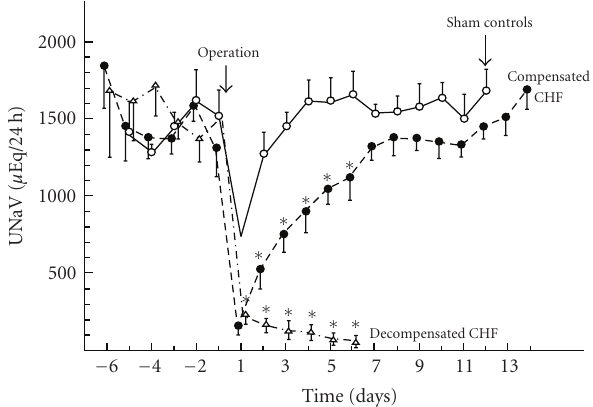
Figure 2: Daily urinary sodium excretion (UNaV) in rats with arteriovenous (AV) fistula and in sham controls. Notice 2 distinct patterns of sodium excretion in rats with AV fistula, compensated and decompensated that are statistically di ff erent ( P < . 05) compared with sham controls. ∗ P < . 05 versus sham-operated